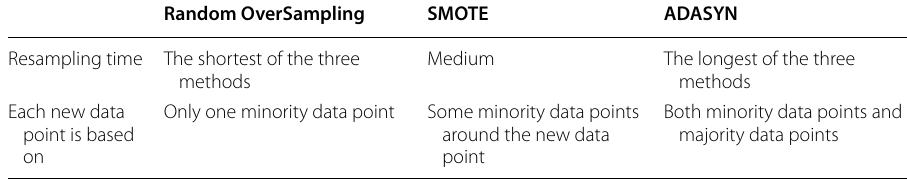
Table 1 Brief comparison of Random Oversampling, SMOTE and ADASYN Random OverSampling SMOTE ADASYN Resampling time The shortest of the three Medium The longest of the three methods methods Each new data Only one minority data point Some minority data points Both minority data points and point is based around the new data majority data on point